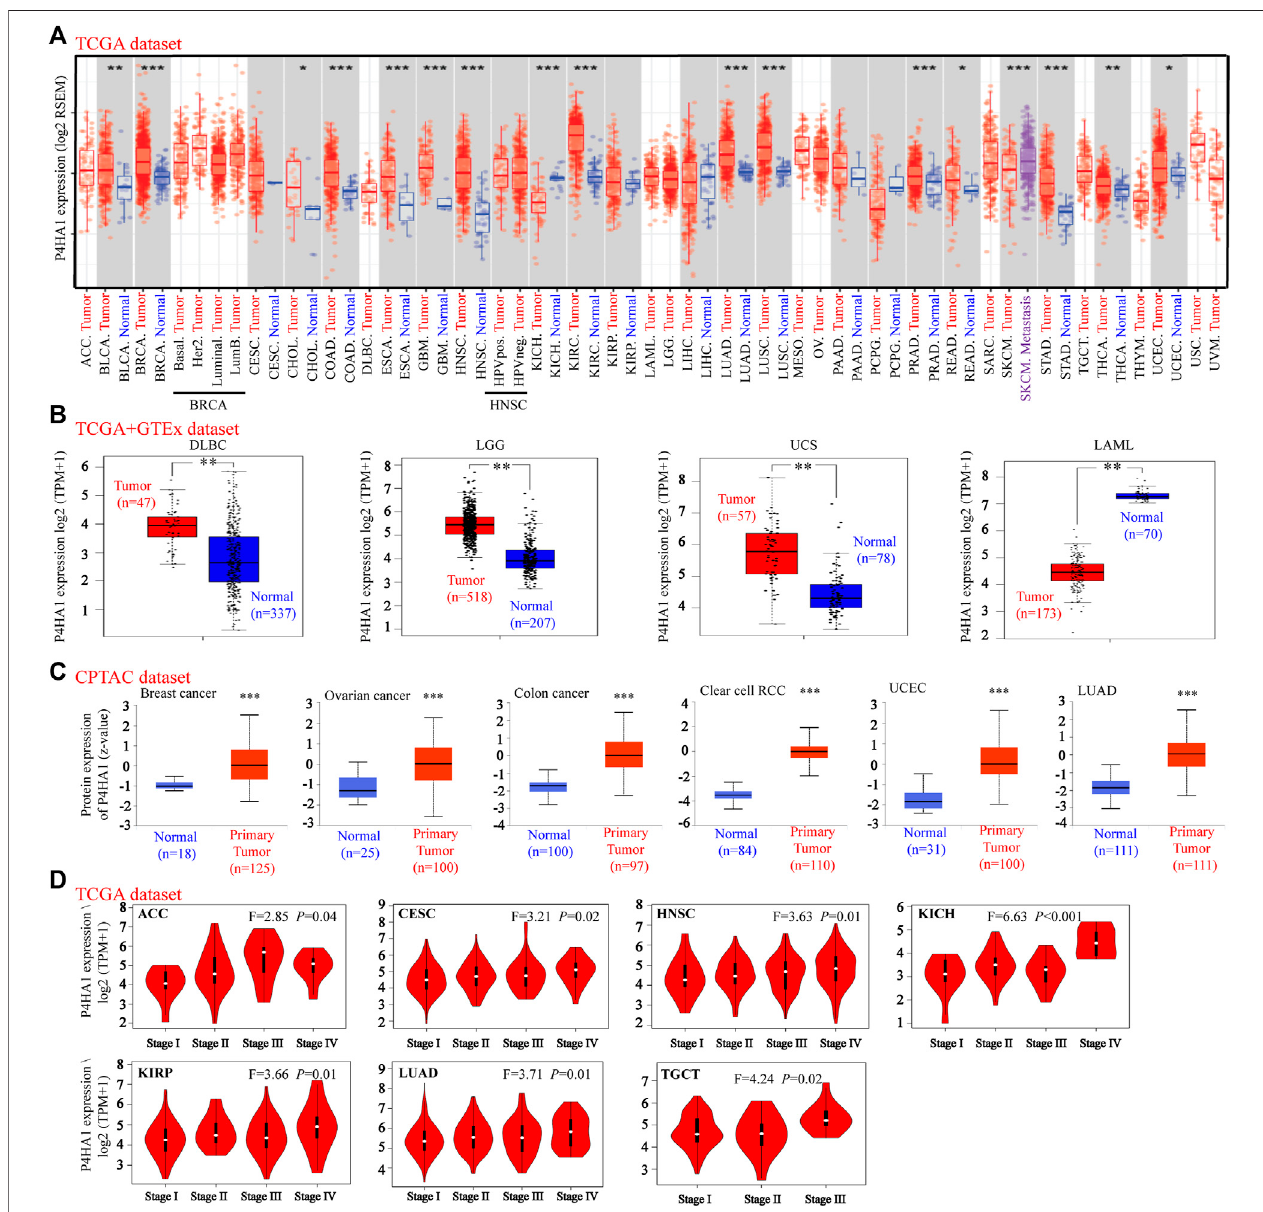
FIGURE 1 | Expression level of P4HA1 in distinct cancers and pathological stages. (A) Expression level ofthe P4HA1 in distinct tumors or speci fi c tumor subtypes was analyzed by TIMER2.0 (http://timer.cistrome.org/). (B) We analyzed the expression level of P4HA1 in DLBC, LGG UCS, and LAML in the TCGA project and GTEx database. (C) Total protein expression level of P4HA1 in BRCA, OV, colon cancer, ccRCC, UCEC, and LUAD was analyzed according to the CPTAC dataset (http:// ualcan.path.uab.edu/). (D) On the basis of the TCGA dataset, the expression level of P4HA1 was analyzed by the main pathological stages (stage I, stage II,